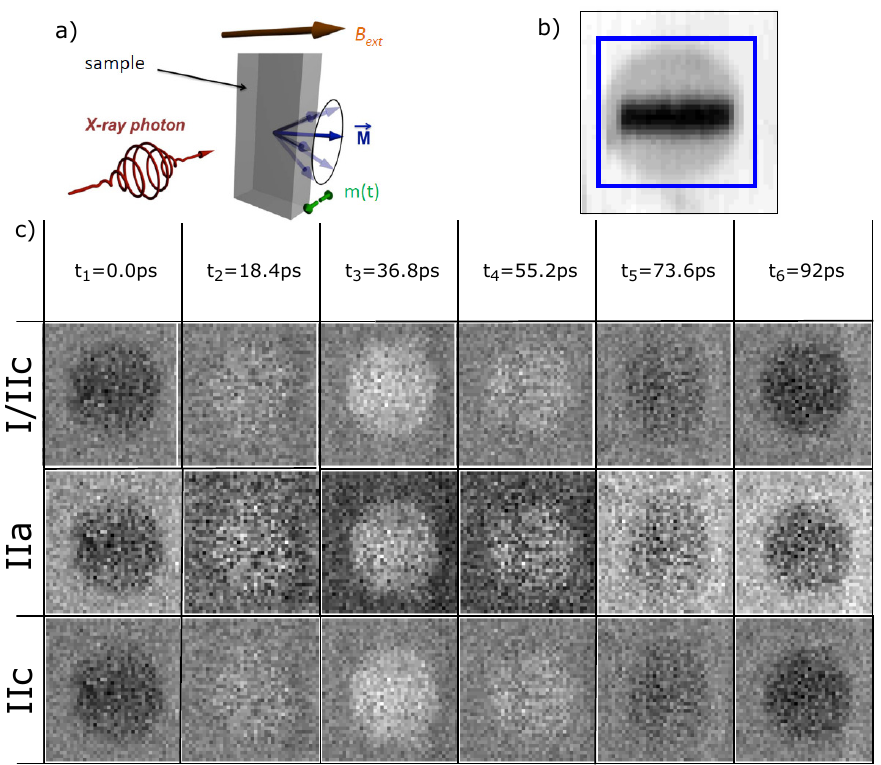
Figure 2. ( a ) sketch of the experimental geometry. The polarized photons hit the sample at normal incidence; the static magnetization is oriented parallel to the external magnetic field B ext . At ferromagnetic resonance, M precesses and a time-dependent out-of-plane component m ( t ) exists; ( b ) the chemical contrast image of the disk stripe sample measured at the Ni- L 3 -edge. Red and blue frames define different regions of interest; ( c ) representation of different evaluation methods for the six phases of the magnetization precession: in the absorption coefficient, the difference is shown obtaining the background corrected microwave on and off measurement. IIa is the ratio between the not background corrected microwave on and off measurement. Applying a background correction to IIa, the images labelled IIb are generated—for details, see text.